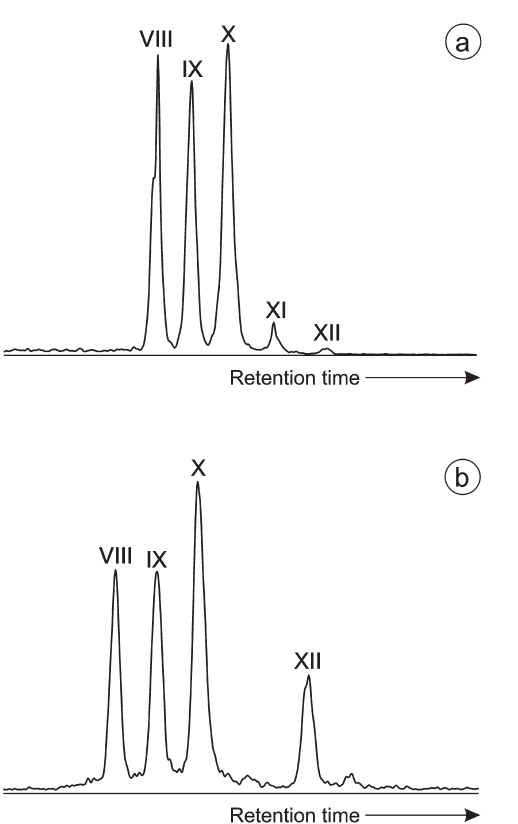
Figure 4. Base peak chromatograms of GDGT distribution: (a) car- bonate crust TTR-11 BS-328G-2 and (b) Napoli mud volcano, East- ern Mediterranean (Pancost et al. 2001 b ). Roman numbers refer to GDGT Compounds shown in Appendix